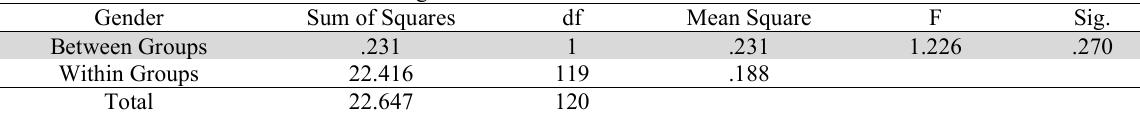
The results of ANOVA test for the effect of gender Gender Sum of Squares df Mean Square F Sig. Between Groups .231 1 .231 Within Groups